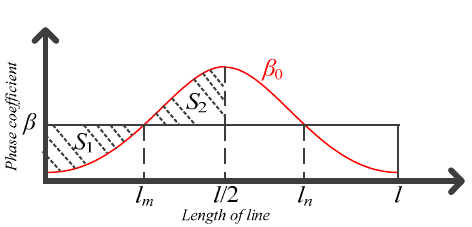
Figure 5. Phase coefficient versus to length of line.